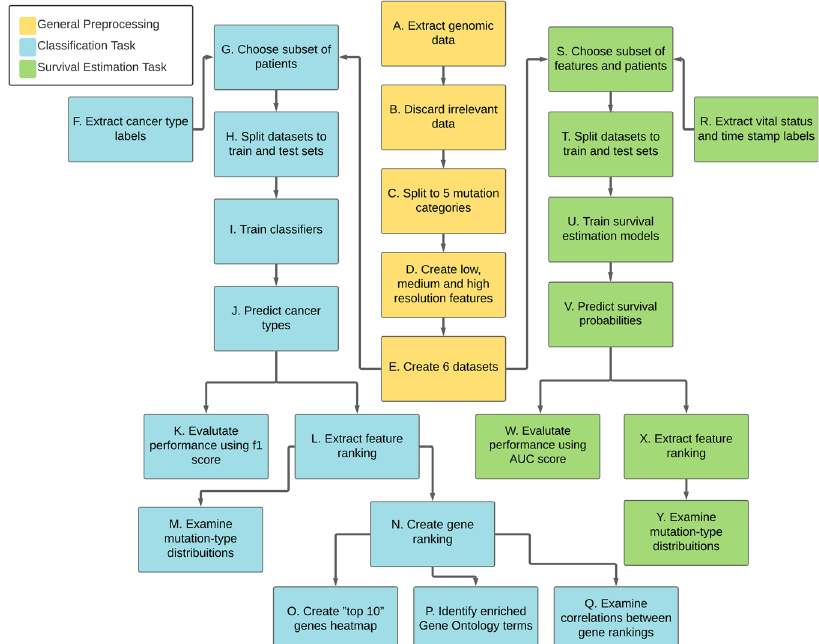
Fig. 2 The fl ow chart of the study. Yellow boxes denote preprocessing steps performed for both tasks. Blue boxes denote steps performed for the cancer type classi fi cation task and green boxes denote steps performed for the survival probability estimation